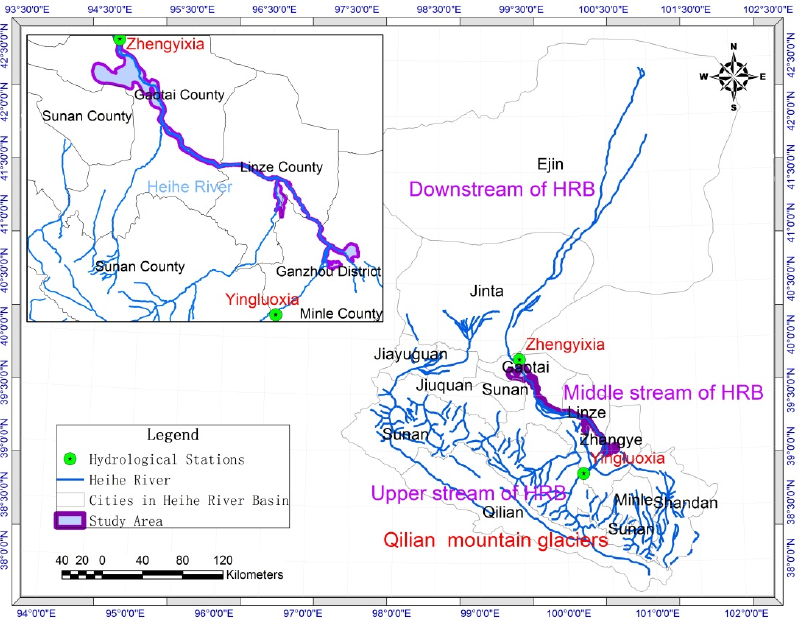
Figure 11. Diagram of hydrological observation sites and different parts of the HRB.